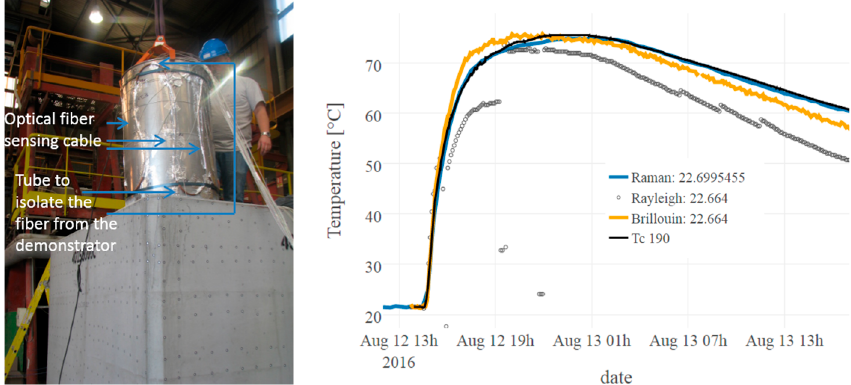
Figure 19. Loose tube implementation and test. ( left ) Picture of the emplacement of a demonstrator of primary waste package, instrumented with optical fibres ( right ) measured temperature on the waste demonstrator, obtained with Raman Rayleigh and Brillouin devices versus reference sensors.